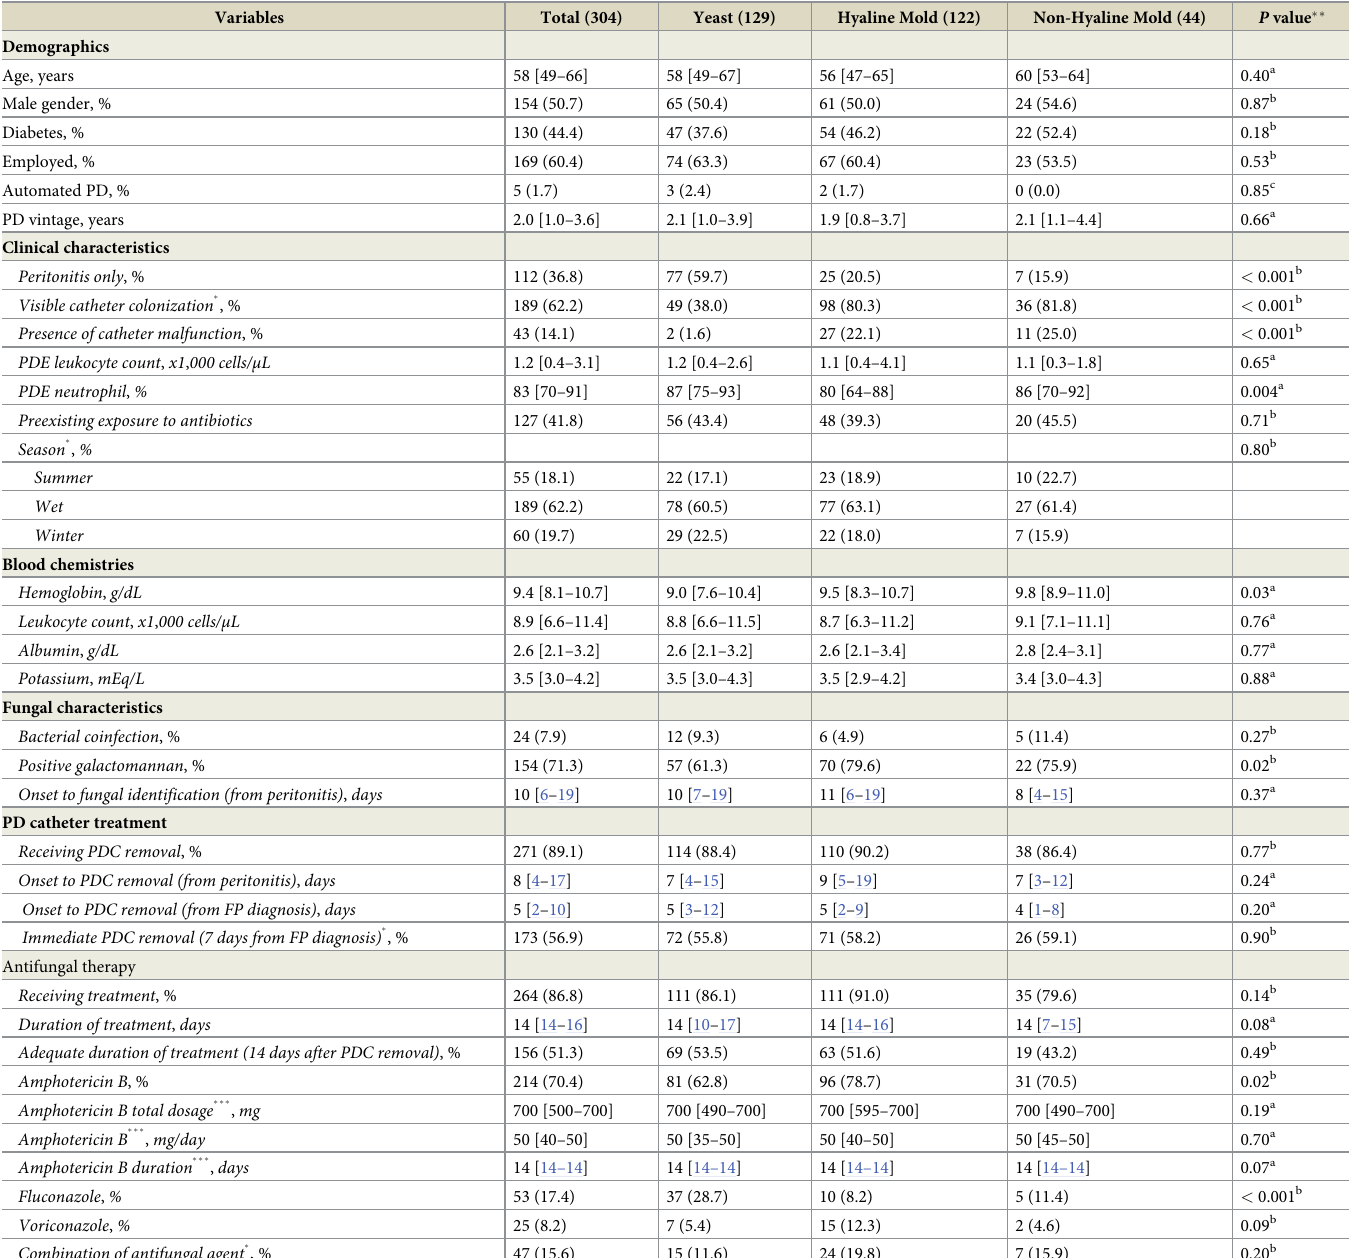
Table 2. Demographic, clinical and laboratory characteristics, and treatment of PD patients with fungal peritonitis according to fungal type.